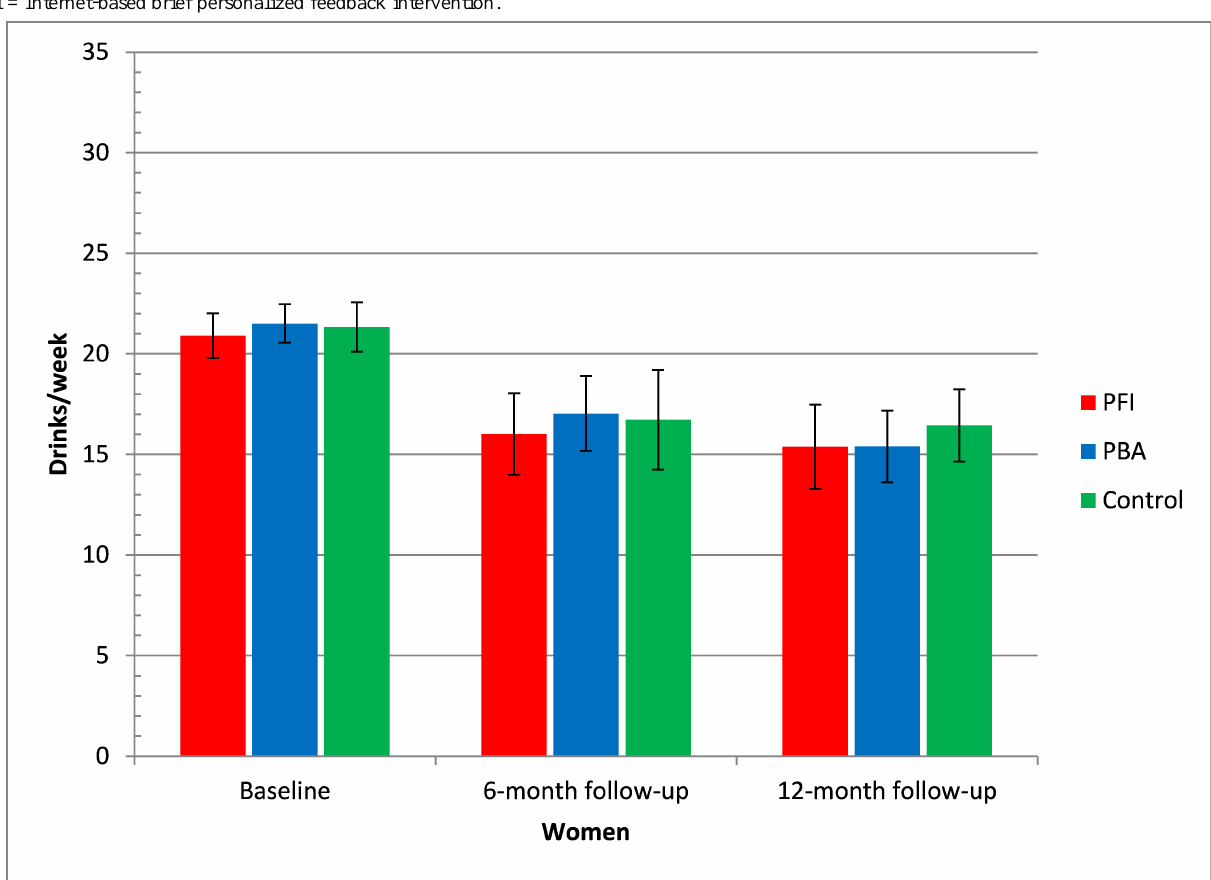
Figure 5. Alcohol consumption at baseline and at 6- and 12-month follow-ups for women based on multiple imputation. Error bars indicate 95% confidence interval. Drinks/week = mean number of standard drinks in a typical week, PBA = Internet-based personalized brief advice intervention, PFI = Internet-based brief personalized feedback